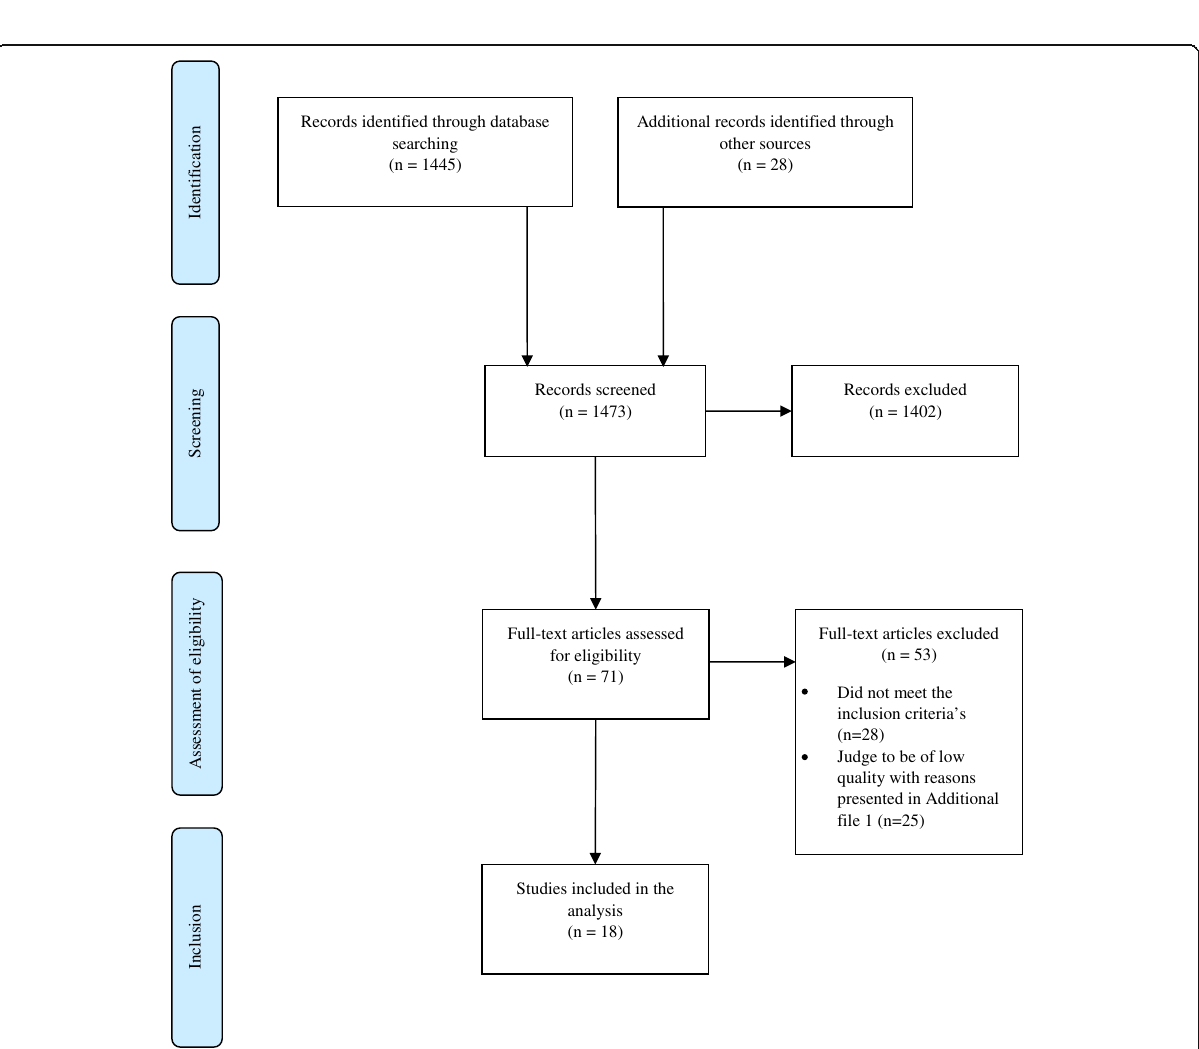
Fig. 2 Flow chart of the work process. PRISMA 2009 Flow Diagram